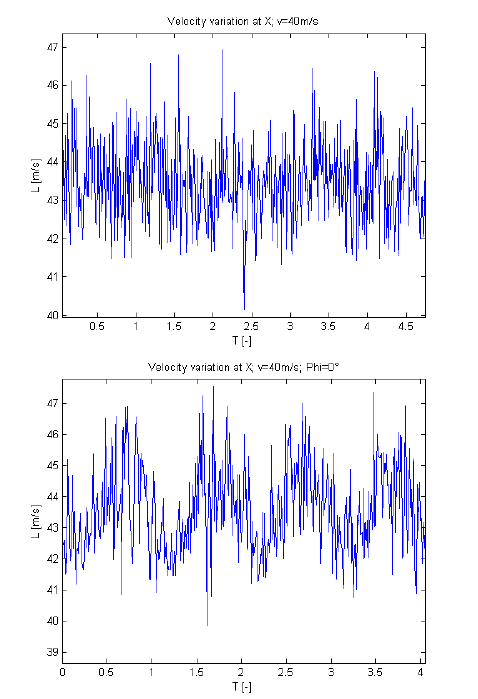
Fig. 5a, b. Velocity variation during 4 periods at point X. Base case versus regime